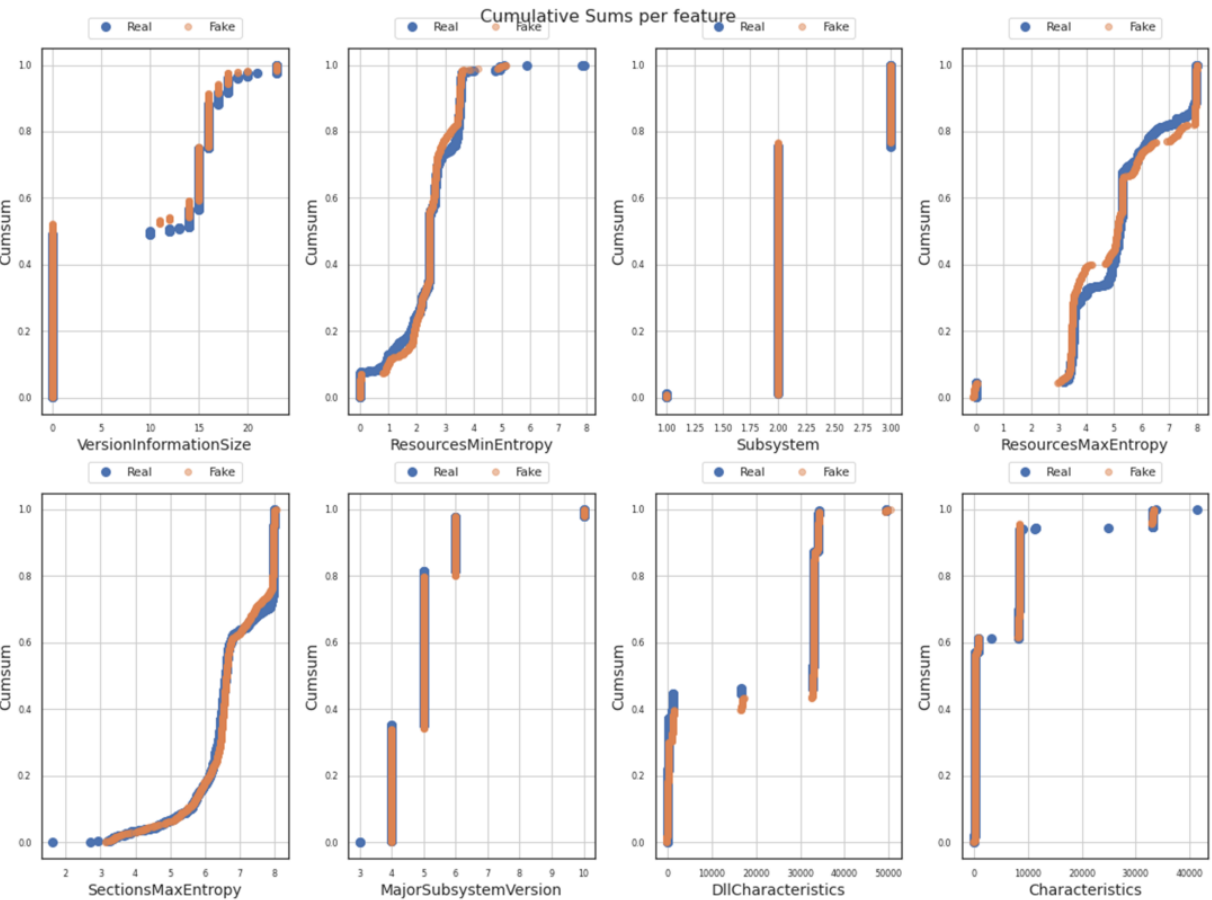
Figure 9. Visualization of cumulative sums for each of eight features of the original (real) and generated (fake) dataset.